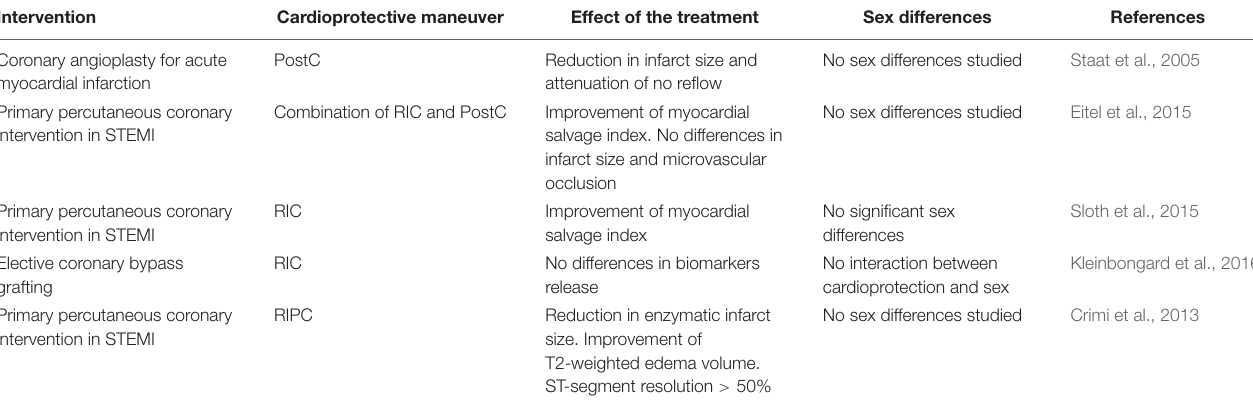
TABLE 1 | Human studies and most relevant clinical trials based on the effect of conditioning maneuvers and their effect in the two sexes.